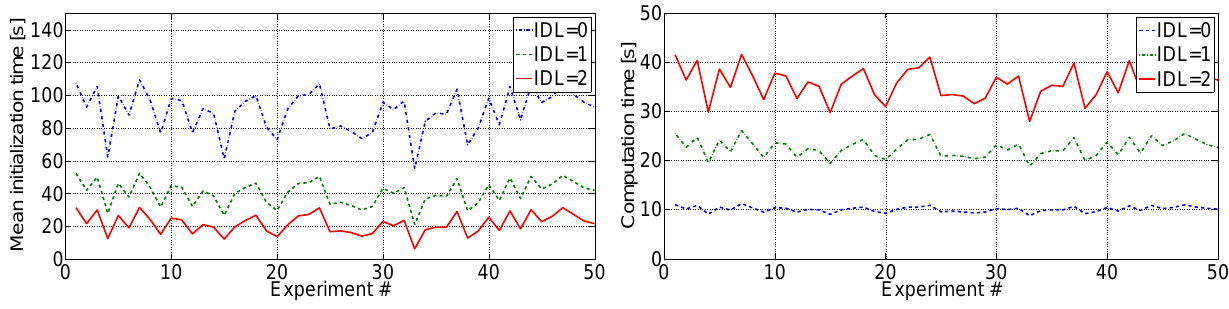
Figure 7. ( Left ) Mean beacon initialization times in 50 experiments with IDL = 0, IDL = 1 and IDL = 2; ( right ) computational times required by the robot to execute the SLAM filter in each entire experiment assuming IDL = 0, IDL = 1 and IDL = 2.